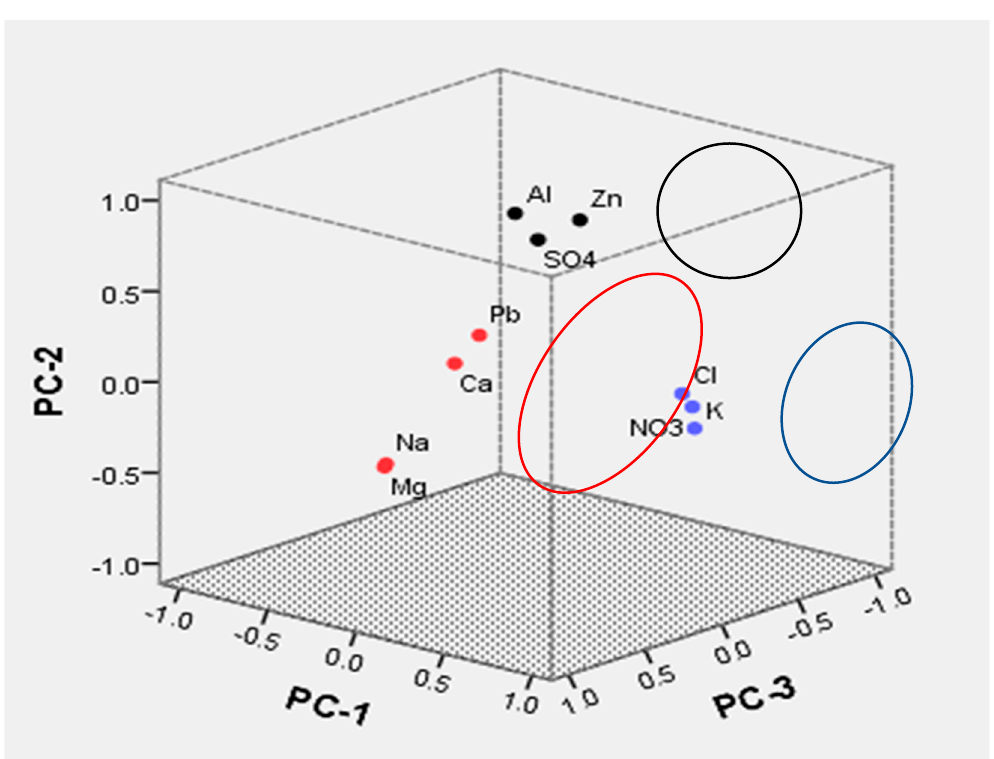
Figure 8. Factor loading plot in three-dimensional rotated space for ions and trace metals in present study. PC-1 (blue circle), PC-2 (black circle) and PC-3 (red circle).